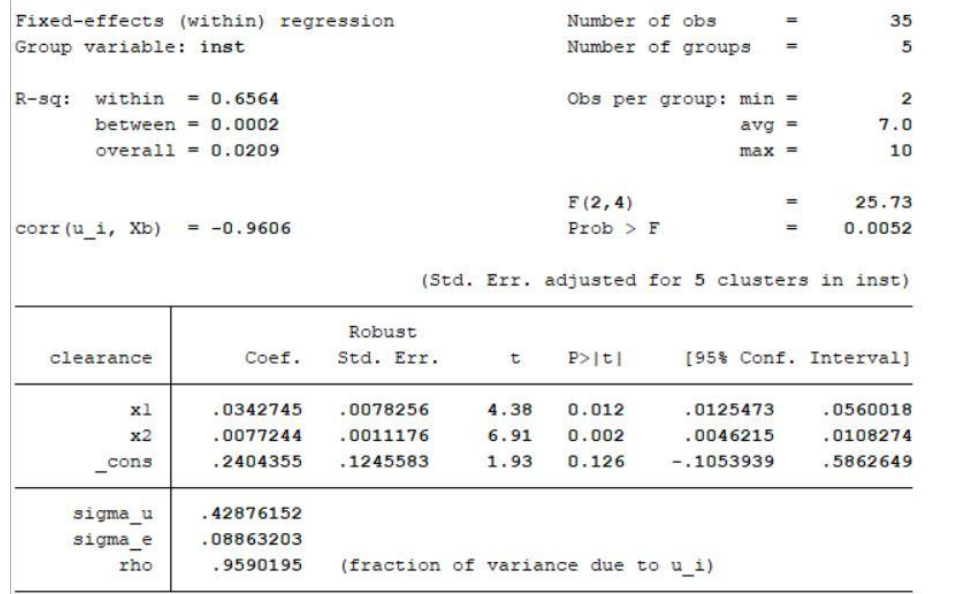
Table 6: Fixed Effect Clearance Rate x1